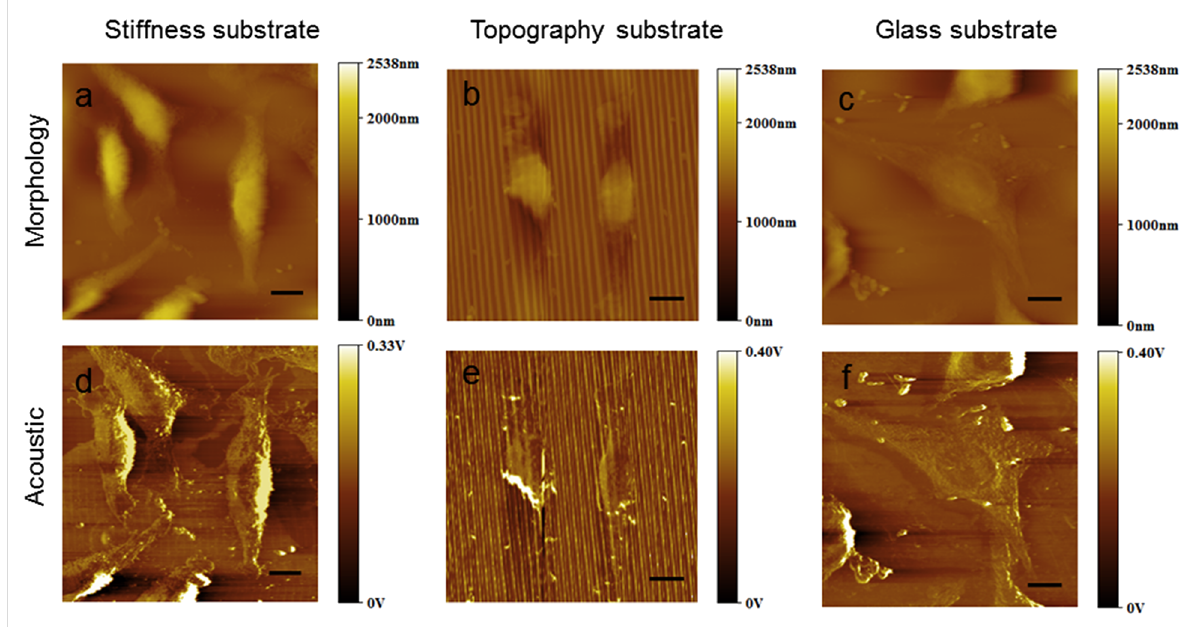
Figure 5: AFAM images of the L929 cells cultured for 48 h on the patterned stiffness substrate (a, d), on the patterned topography substrate (b, e) and on the reference glass substrate (c, f). Scale bars: 10 μ